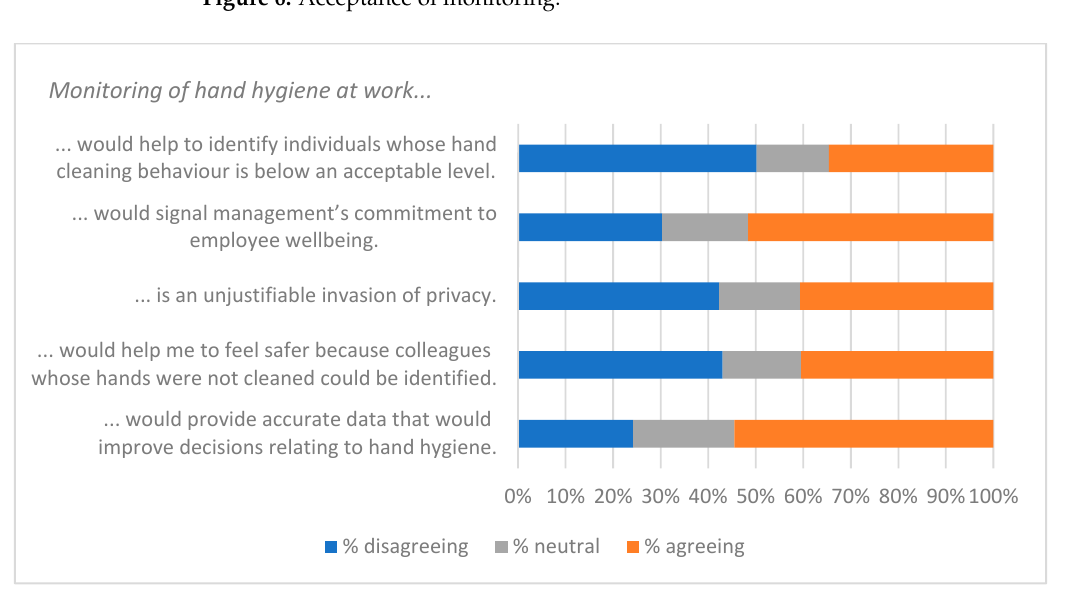
Figure 7. Agreement with monitoring.